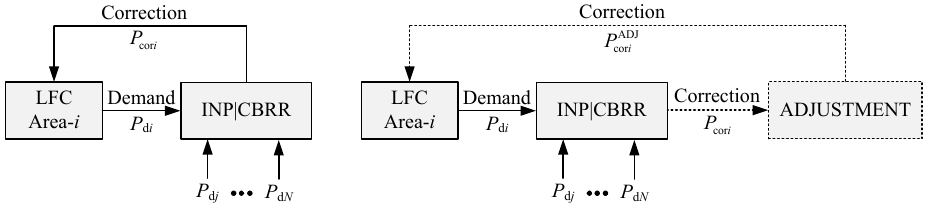
Figure 1. Schematic diagram of the LFC, INP, CBRR ( left ) and the function for correction power adjustment ( right